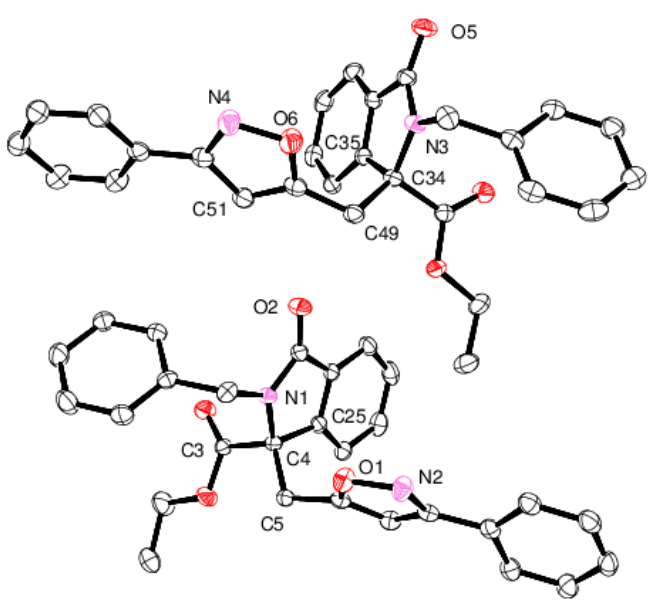
Figure 3. Content of the asymmetric unit in the racemic crystal of 4a (P2 1 /c space group) showing the presence of both S (over C34 atom) and R (over C4 atom) enantiomers. Hydrogen atoms have been omitted for clarity. Thermal ellipsoids are plotted at 50% probability level. Selected bond lengths (Å)